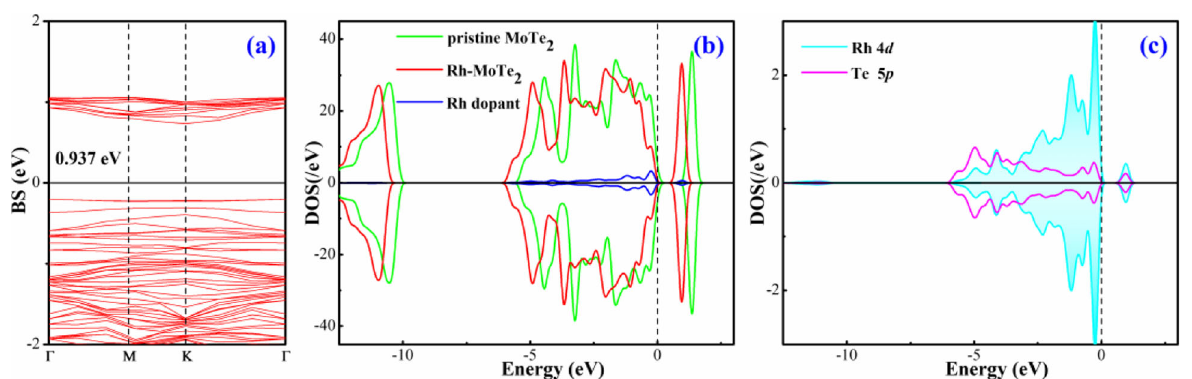
Fig. 2 a BS of Rh-MoTe 2 monolayer; b DOS comparison between pristine and Rh-doped MoTe 2 monolayer; and c orbital DOS of bonding Rh and Te atoms. The Fermi level is